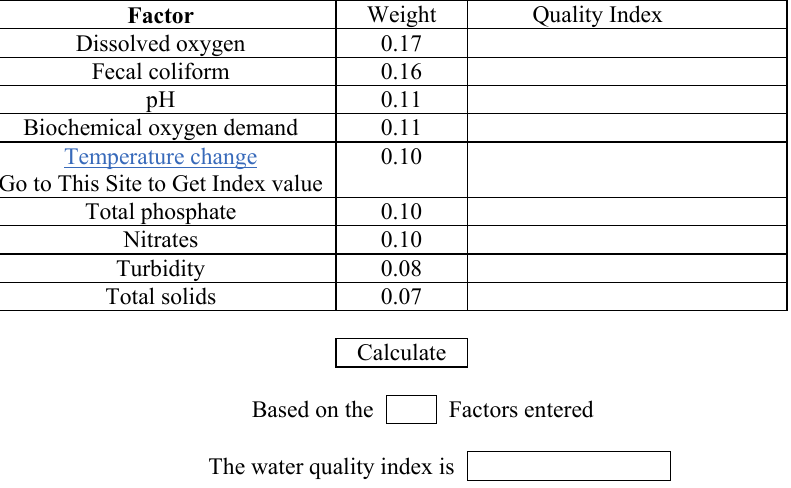
Fig. 1. NSF software for determining the water quality index Using the results obtained from the tests carried out on the samples of raw water and determination of the seasonal average, the qualitative value of each one of the parameters were calculated.